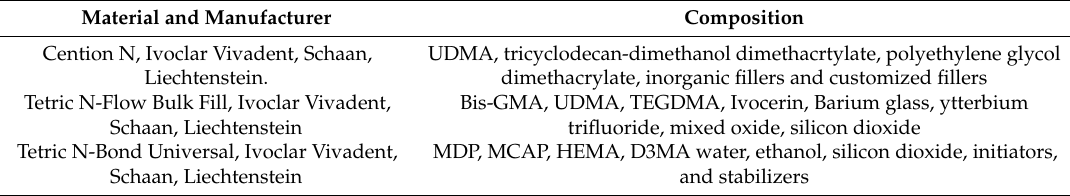
Table 1. Materials used in the